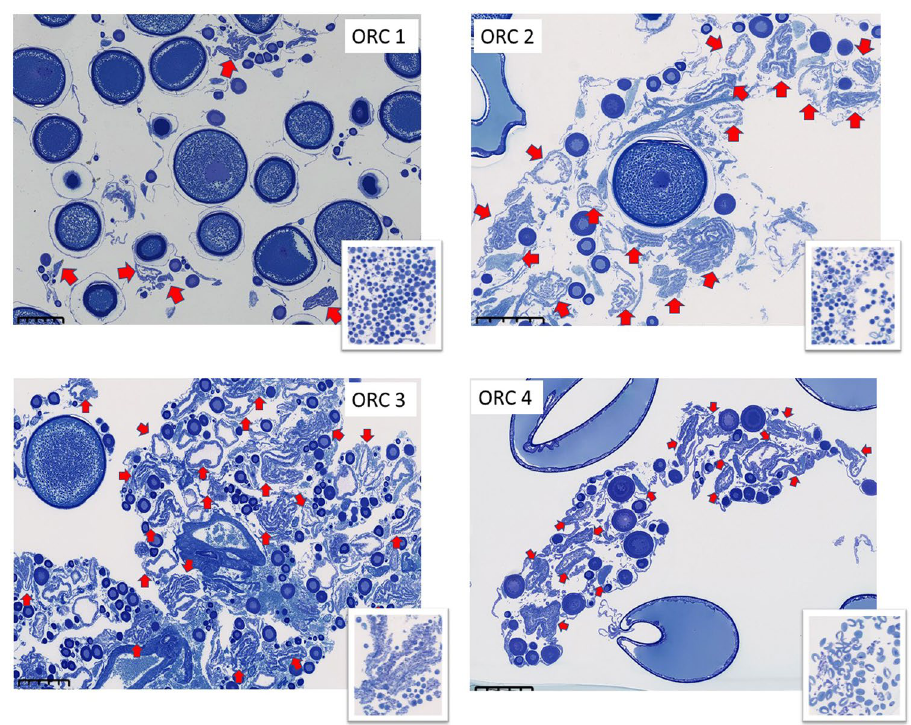
Figure 5. Post-ovulatory follicles (POFs) in each of the four ORCs. Red arrows indicate POFs. Scale bar = 500 µ m. Lower magnification micrographs of each representative sample are shown on the bottom right of each